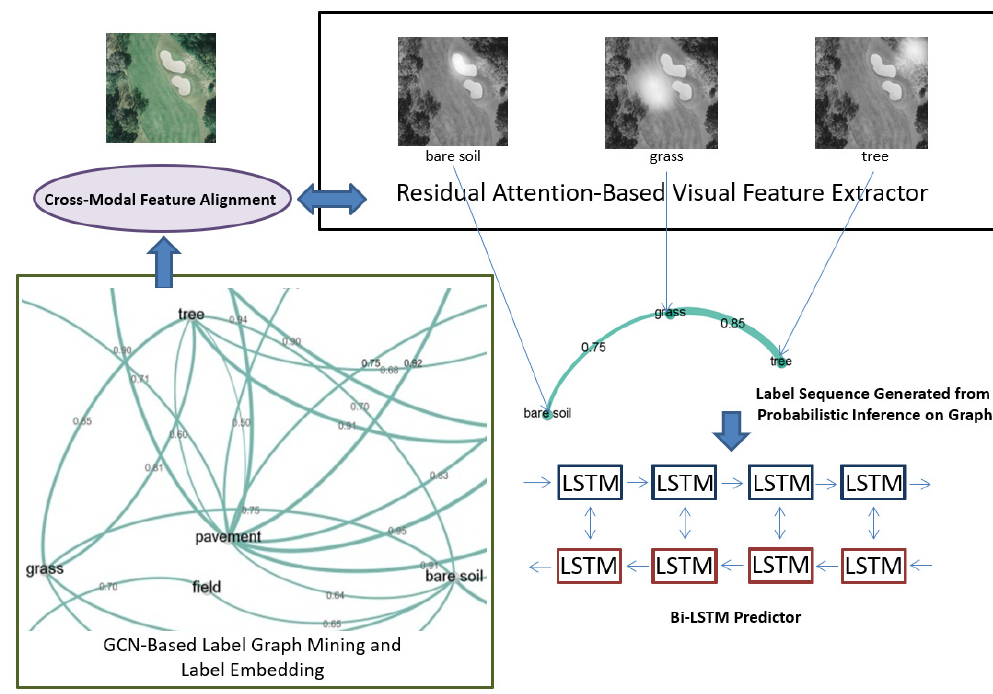
Figure 3. The proposed CM-GM